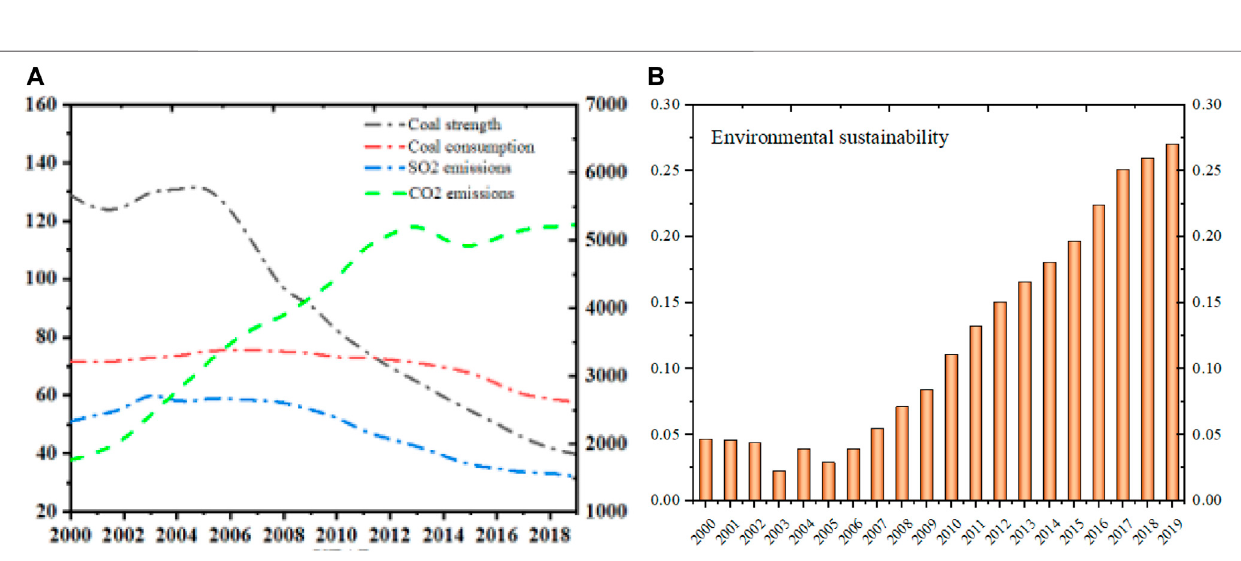
Frontiers in Energy Research |